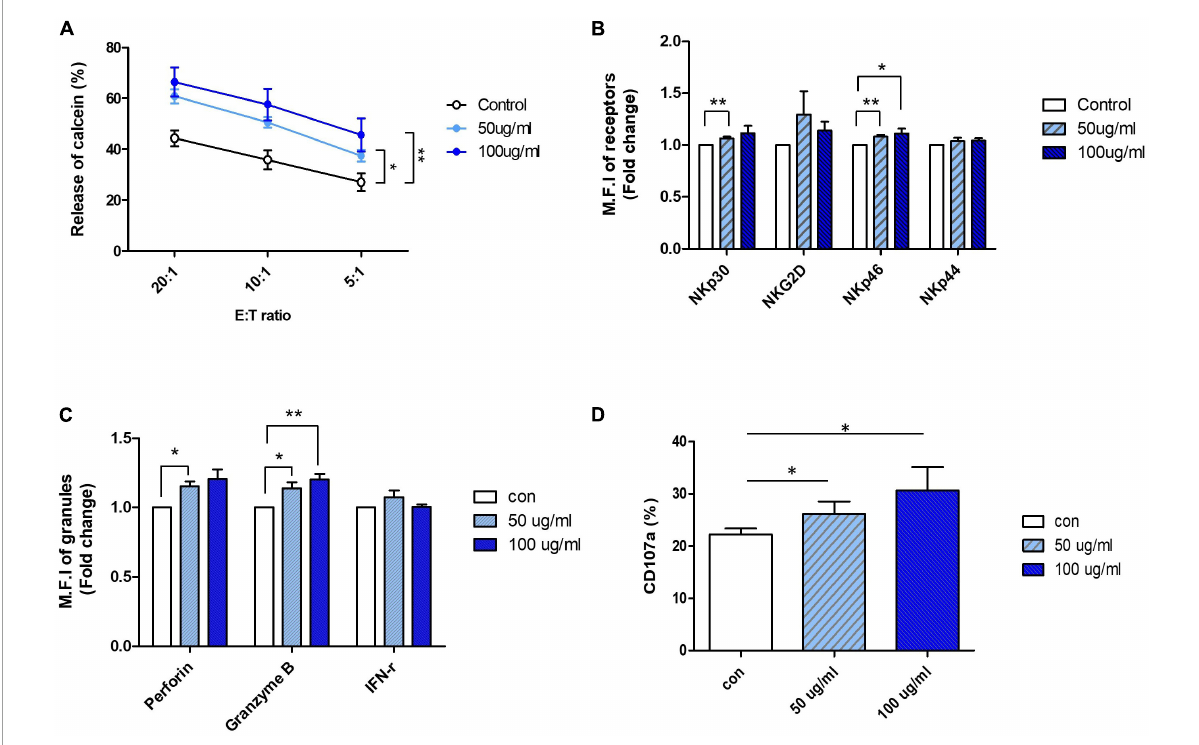
FIGURE1 Aurantii Fructus Immaturus (AFI) enhance cytolytic activity of NK-92 cells. (A) NK-92 cells were cultured in the absence (empty) or presence of 50 µ g/ml (sky blue) or 100 µ g/ml (blue) of AFI for 24 h and cytotoxicity against K562 cells was examined. (B) NK cells were cultured in the absence (empty) or presence of 50 µ g/ml (sky blue) or 100 µ g/ml (blue) of AFI for 24 h. Expressions of NK receptors, including NKp30, NKG2D, NKp46, and NKp44 were detected by flow cytometry. Graphs represent the average values of fold changes in mean fluorescence intensity (MFI) of three independent experiments which were calculated based on the fact that MFI of each control is defined as 1. (C) Expressions of granules (Perforin, Granzyme B) and IFN- γ level in NK cells were analyzed by intracellular staining and flow cytometry. Graph represents the average fold changes in MFI of three independent experiments compared to control for each experiment. (D) Expression of CD107a on the surface of NK cells detected by flow cytometry. Graph indicates mean value of CD107a + expression percentage for three independent experiments. Bars represent the mean ± SEM of three independent experiments ∗ p < 0.05 and ∗∗ p <